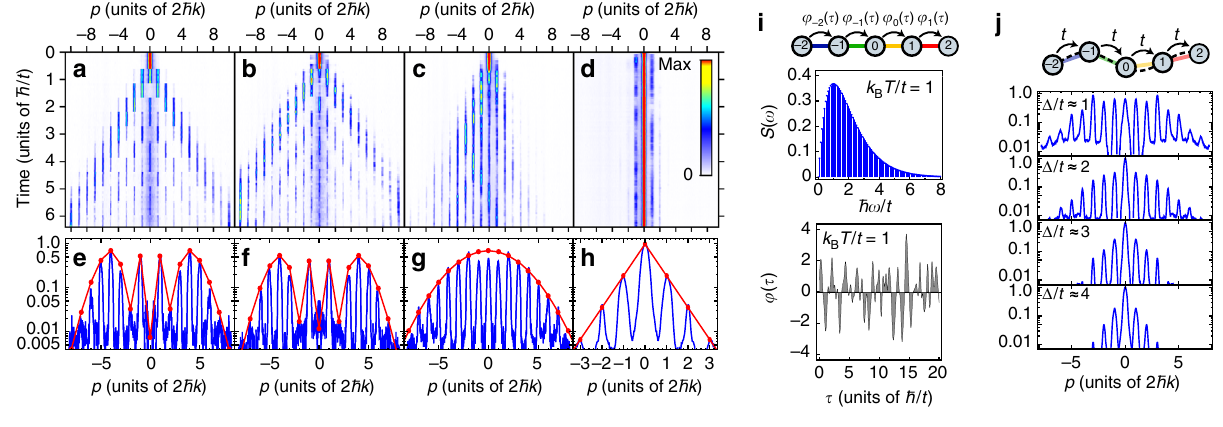
Fig. 2 Atomic quantum walks in regular and disordered momentum-space lattices. a – d Nonequilibrium quantum walk dynamics of 1D atomic momentum distributions vs. evolution time for the cases of a uniform tunnelling, b random static tunnelling phases, c random, dynamically varying tunnelling phases characterised by an effective temperature k B T / t = 0.66(1) and d pseudorandom site energies for Δ / t = 5.9(1). e – h Integrated 1D momentum distributions (populations in arbitrary units; symmetrised about zero momentum) for the same cases as in a – d , after evolution times τ = (2.96(2) ħ / t , 2.51(2) ħ / t , 3.80(3) ħ / t , and an average over the range 5.1(1) to 6.4(1) ħ / t ) for e – h . For e , f , we compare to quantum random walk distributions of the form P n / j J n ð 2 τ t = (cid:2) h Þj 2 , for g we ffiffiffiffiffiffiffiffiffiffiffi p compare to a Gaussian distribution P n / e (cid:3) n 2 = 2 σ 2 n for σ n ¼ 2 τ t = (cid:2) h , and for h we compare to an exponential distribution P n / e (cid:3)j n j = ξ . i Annealed disorder realised with tunnelling phases φ ( τ ) that vary dynamically with time τ . Phases contain N = 50 frequency components ω that sample an ohmic spectrum S ( ω ), shown here peaked at effective temperature k B T / t = 1. j Transport under pseudorandom site energies following the form ε n ¼ Δ cos ð 2 π bn þ ϕ Þ of an incommensurate cosine potential ( dashed line ). As in h , 1D momentum distributions are shown for varying pseudodisorder strengths Δ /